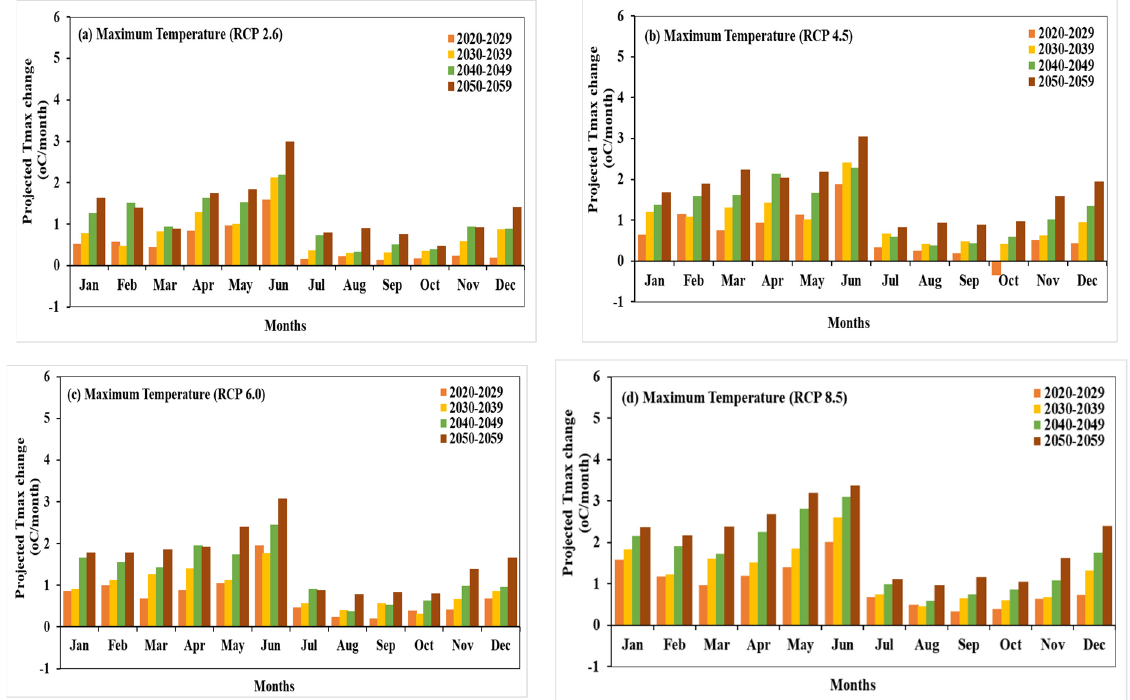
Figure 11. Projection of maximum temperature change for 10 years of the interval during 2020–2060 for ( a ) RCP 2.6, ( b ) RCP 4.5, ( c ) RCP 6.0, and ( d ) RCP 8.5.